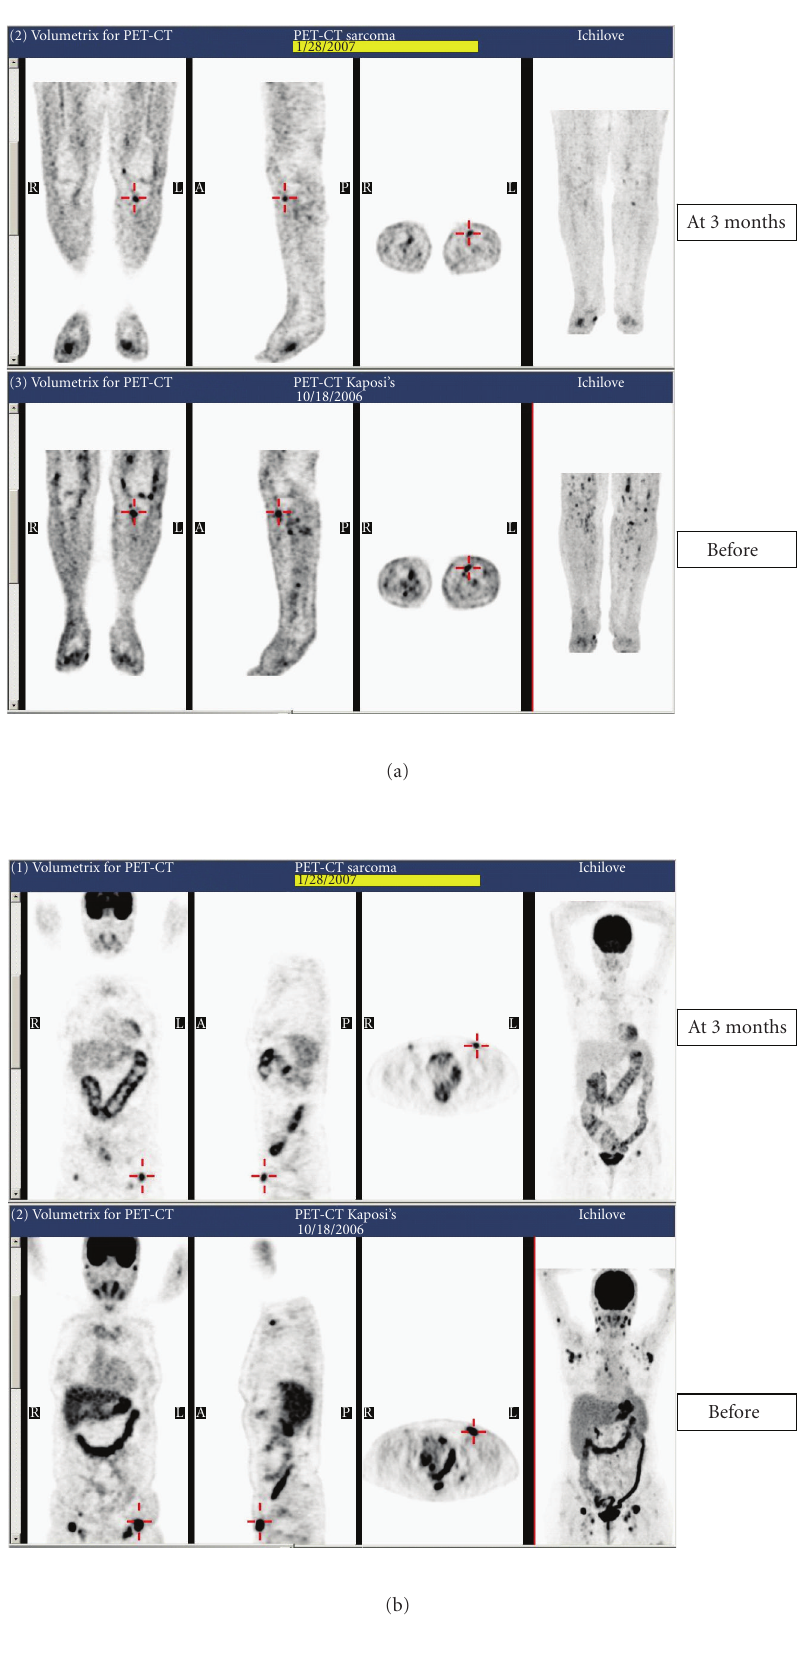
Figure 1: PET-CT at initiation and at completion of almost 4-month rapamycin